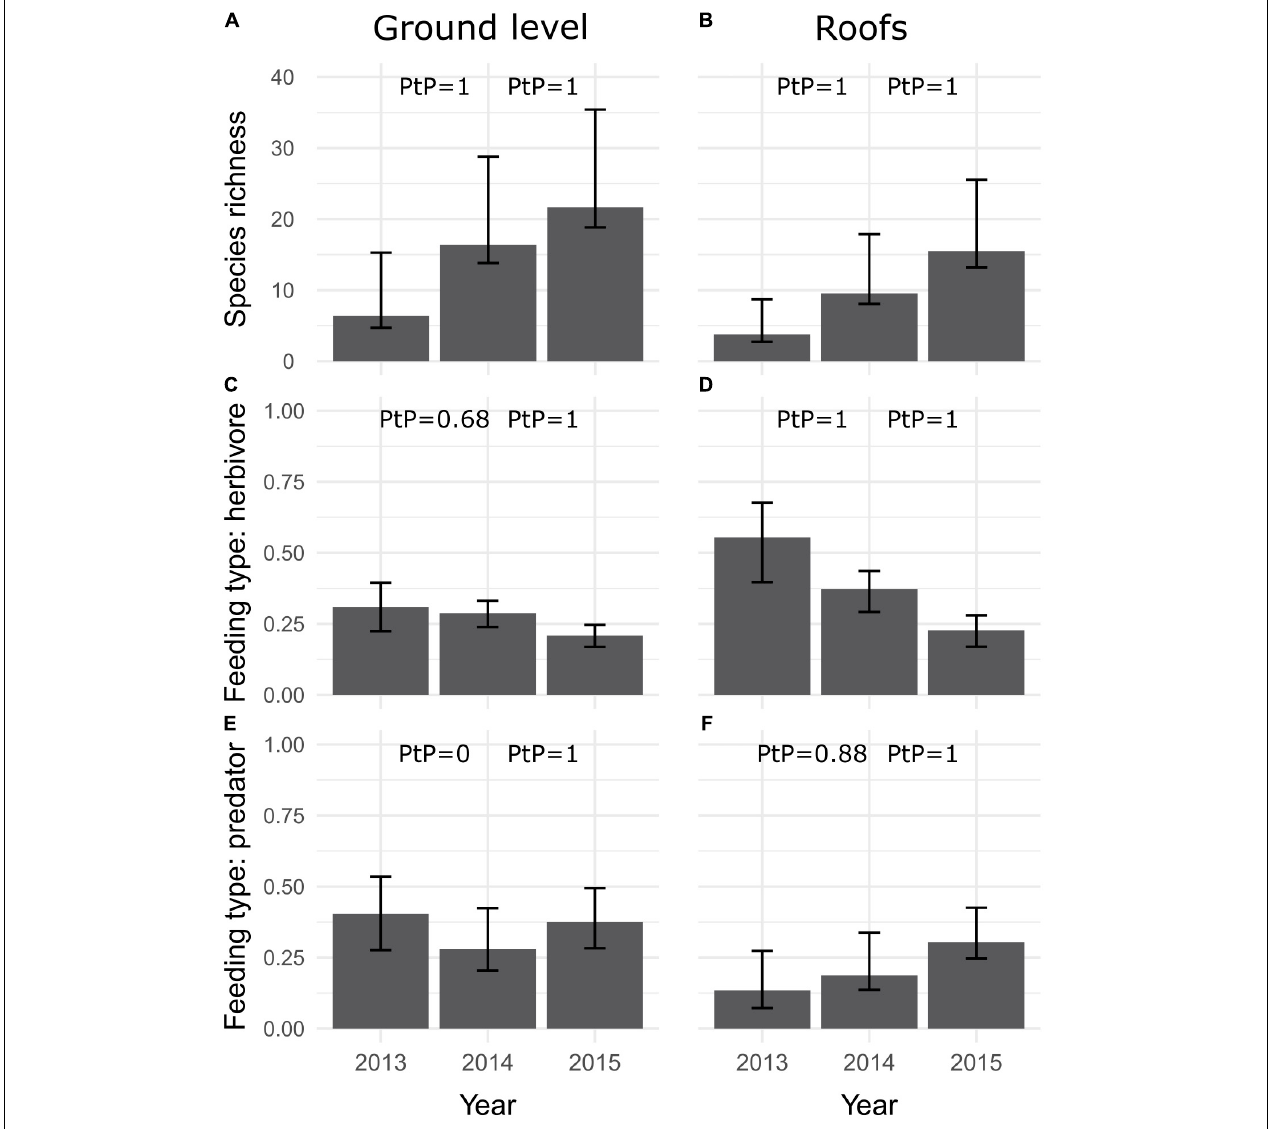
FIGURE 4 | Prediction from the roofs vs. ground model for species richness (mean ± SE) (A,B) , proportion of herbivores (C,D) and proportion of predators (E,F) across years. Plots on the left represent ground level sites and plots on the right, roofs. PtP = Posterior probability, where each value is for adjacent prediction scenarios being either larger (A,B,E,F) or smaller (C,D) in the latter